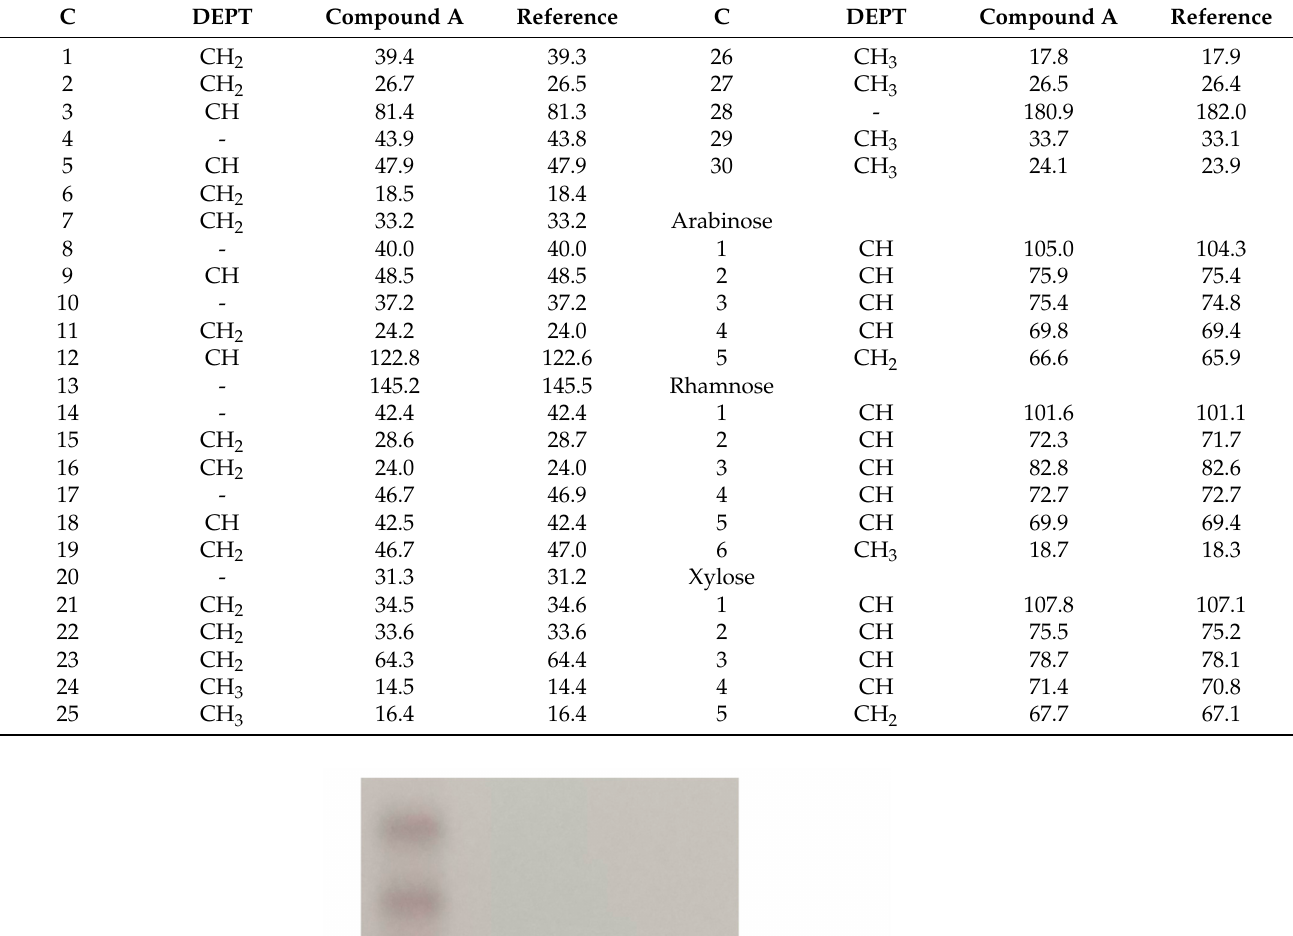
Table 2. 13 C-NMR data of compound A in pyridine-d5 compared with literature data.